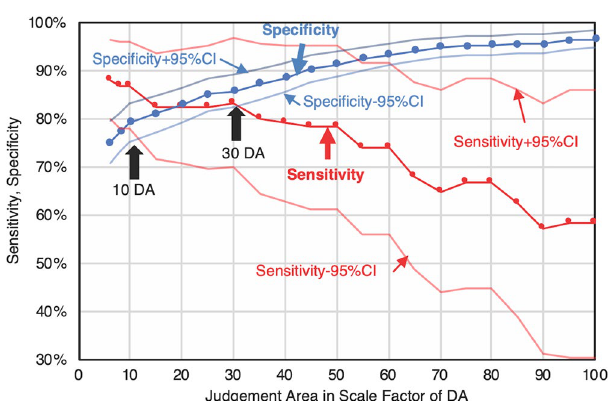
Figure 4. Influence of JA on the sensitivity and specificity in error analysis. Influence on the results of error analysis of changing JA using the contingency table (Table 2). Previous studies using normal-field fundus cameras suggested that 10 DA is the threshold of NV occurrence, but more recent studies using UWF suggest that 30 DA, or even 50 DA, is the threshold. Here, sensitivity and specificity remained at almost 80% until around 30